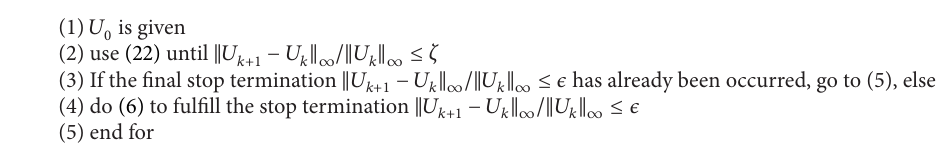
Algorithm 1: The hybrid algorithm for computing polar decomposition.